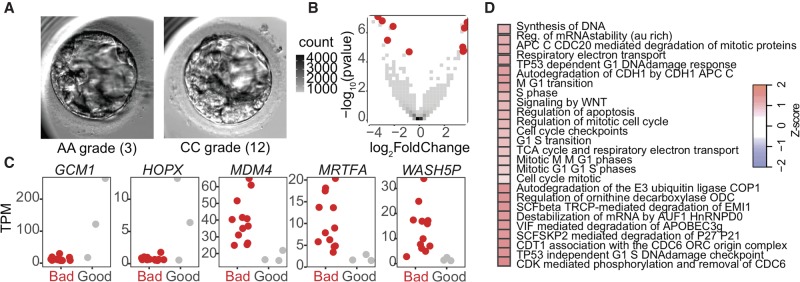
Morphology-associated gene sets. (A) Representative good morphological quality (AA grade on Gardner scale) and bad morphological quality (CC grade on Gardner scale) blastocysts from our cohort. (B) Volcano plot of differentially expressed genes from morphology-based differential expression analysis. Red indicates significant differential expression (BH-adjusted P-value <0.05). (C) Jitter plots of selected significant differentially expressed genes from the morphology-based differential expression analysis (adjusted P-value <0.05). (D) Reactome gene set enrichment analysis of gene expression from morphology-based differential expression analysis. Red indicates increase in gene set expression in “good” samples.